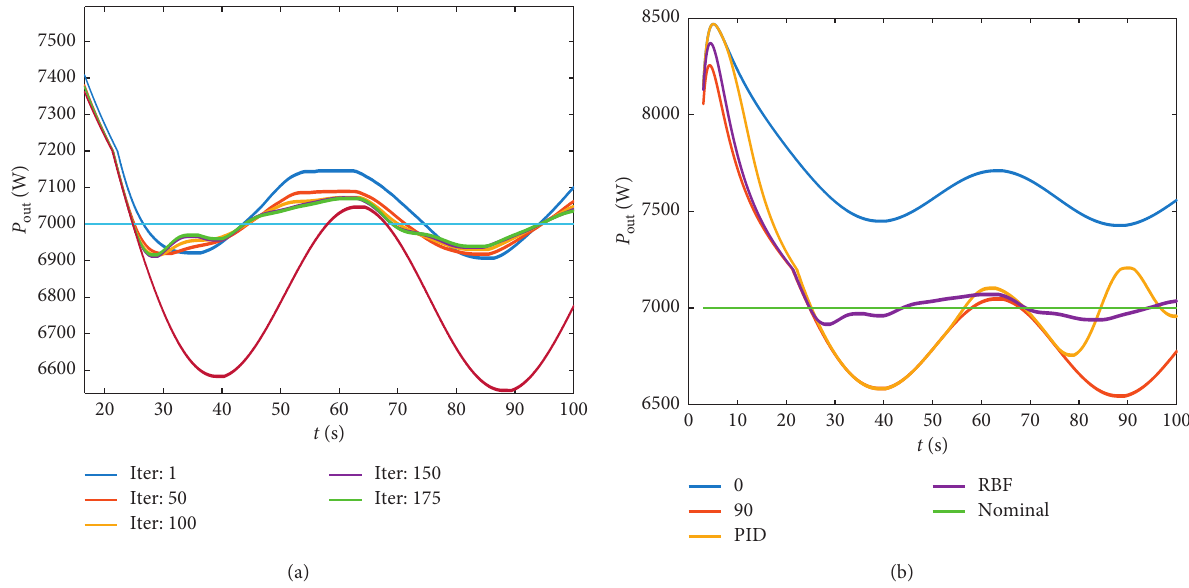
Figure 7: Output power for learning iterations from 1 to 175 with sinusoidal wind speed (a). Output power for different control strategies when the neural controller has learned (b).